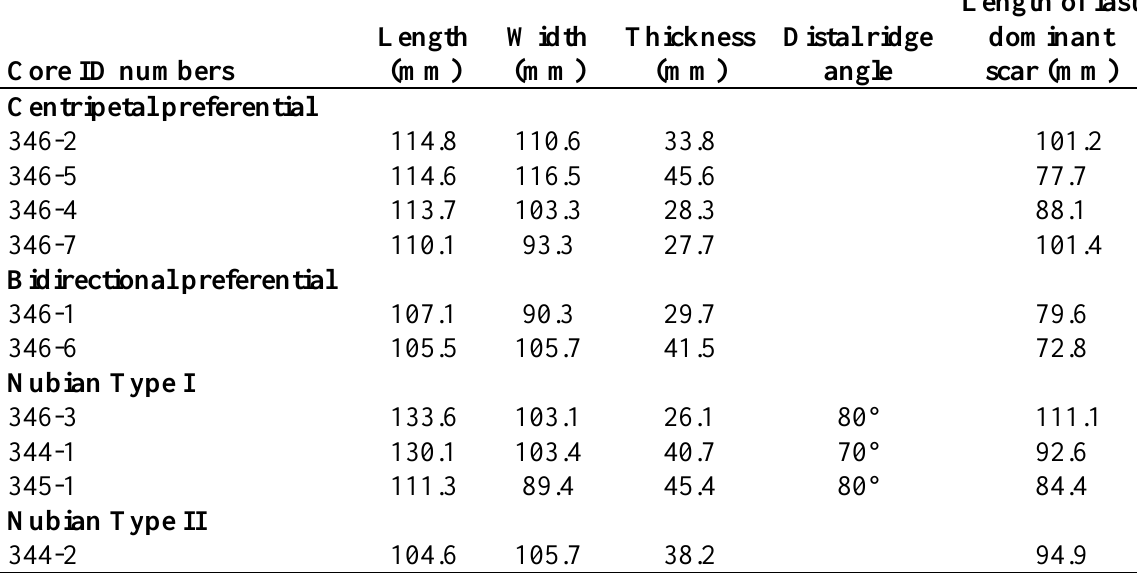
Table 1. Dimensions of collected cores from Nahal Paran